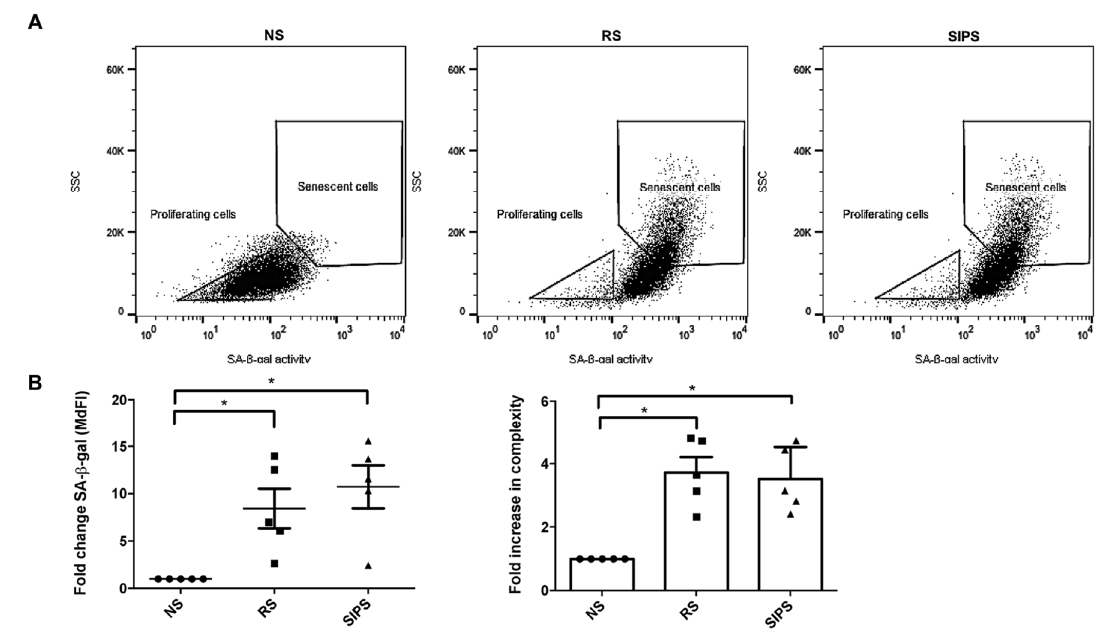
Figure 4. Flow cytometry gating strategy to select senescent fibroblasts. ( A ). Dot plots show that the less complex and less bright cells (low SA-ß-Gal activity) correspond to the NS or proliferating fibroblast population and are more complex and brighter (significant SA-ß-Gal activity) RS and SIPS populations. ( B ). SA-ß-Gal activity and complexity in NS (black circle), RS (black square), and SIPS (black triangle). Each bar represents the mean ± SEM of five independent experiments (* p < 0.05, Kruskal–Wallis-Dunn’s test).